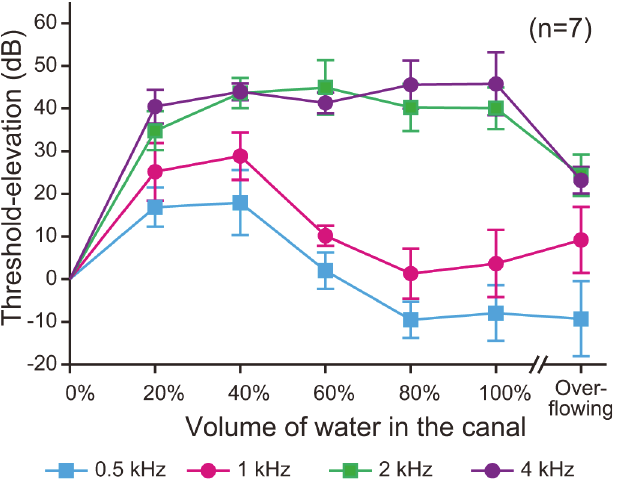
Fig 5. Threshold-shifts by the seven water-injection conditions in cartilage conduction. Threshold- shifts from the 0%-water injection condition were described. The water injection first elevated the thresholds at all frequencies. Beyond 60% of the ear canal, the thresholds at 0.5 and 1 kHz were improved. In addition, when the injected water overflowed to touch the transducer, the thresholds at 2 and 4 kHz were improved. Vertical bars indicate standard